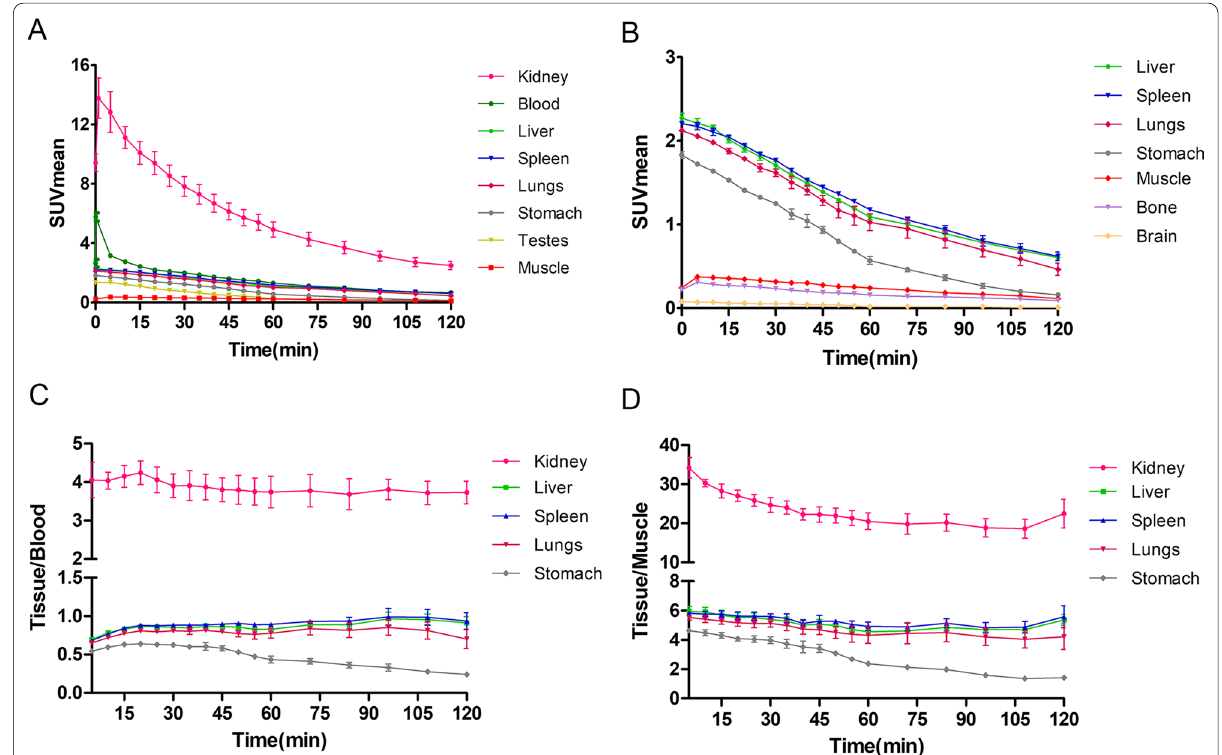
Fig. 5 A, B Cynomolgus major organs dynamic time-activity curves; C , D Major organs tissue-to-blood and tissue-to-muscle ratios with